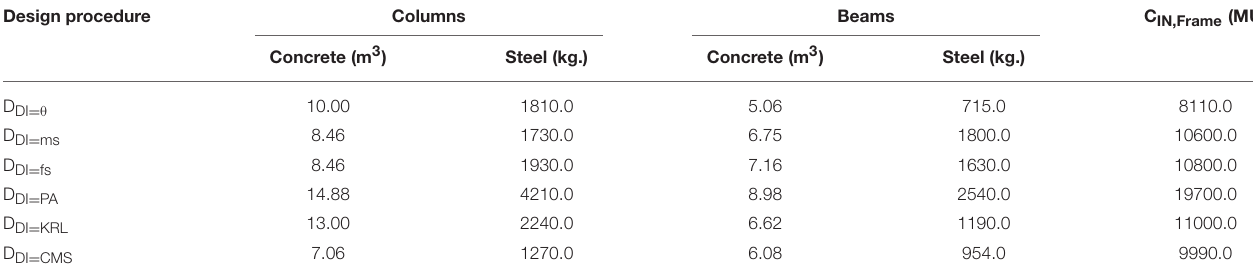
TABLE 3 | Three-story test example: Concrete volume and steel weight corresponding to the optimized designs based on six DIs. Design procedure